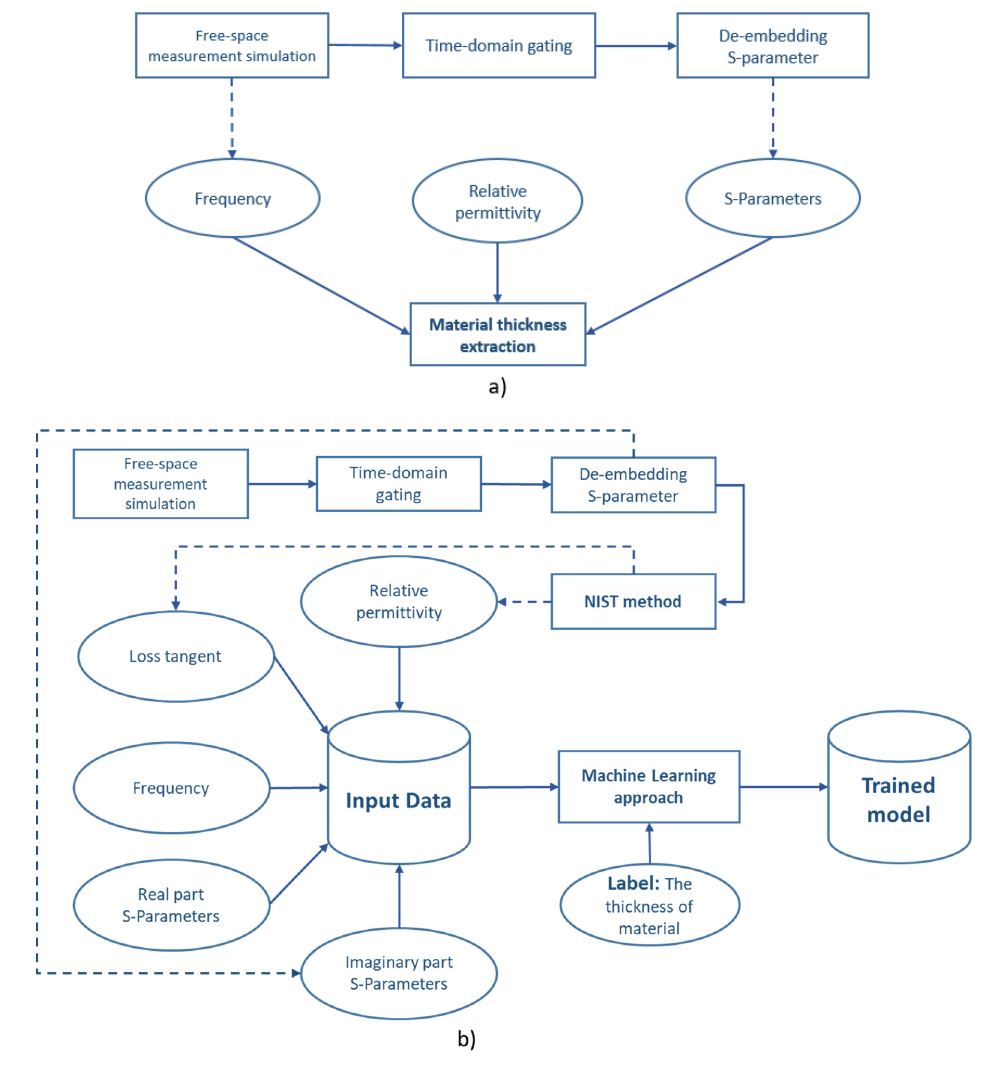
Figure 1. Block diagram of ( a ) the conventional method and ( b ) the proposed